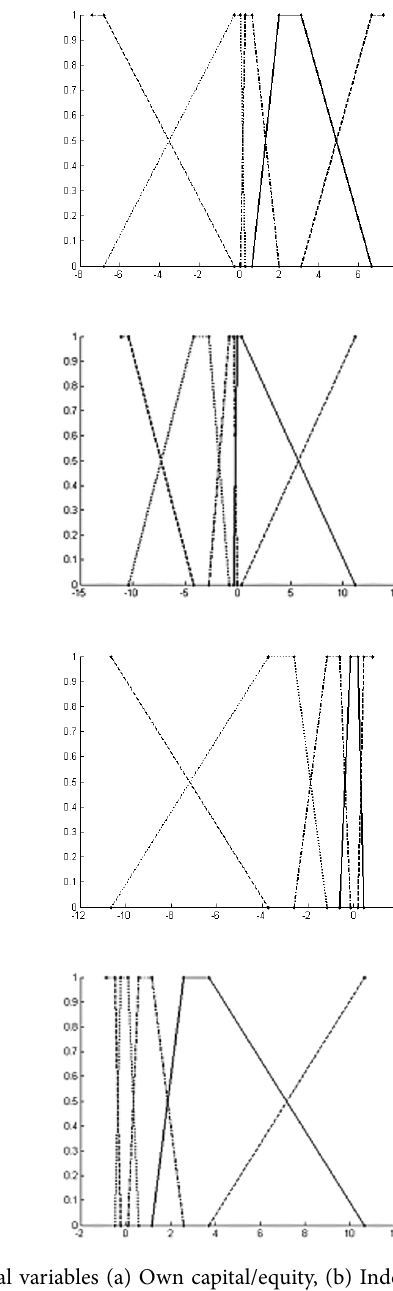
Fig. 2. Linguistic representation of eight financial variables (a) Own capital/equity, (b) Indebtedness sources, (c) Past due and doubtful loans (net value)/total loans portfolio (net value), (d) Past due and doubtful claims (net value)/total assets (net value), (e) Past due and doubtful claims (net value)/own capital, (f) ROE, (g) The rate of profit, (h) Activity cost and their trapezoidal approximations. Each trapezoid correspond to one linguistic term (very low – VL , low – L , average – A , high – H and very high – VH